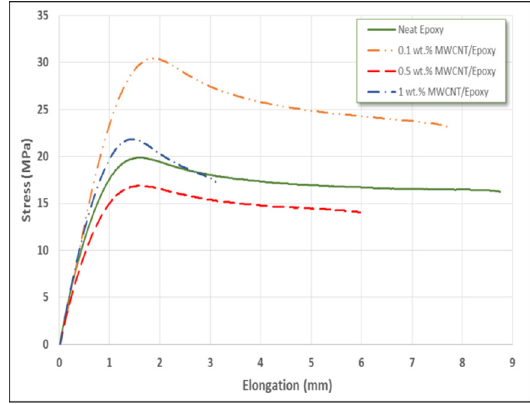
Fig. 6. Stress-Strain behaviorsof MWCNT/Epoxy nanocomposites with different MWCNT ratios.